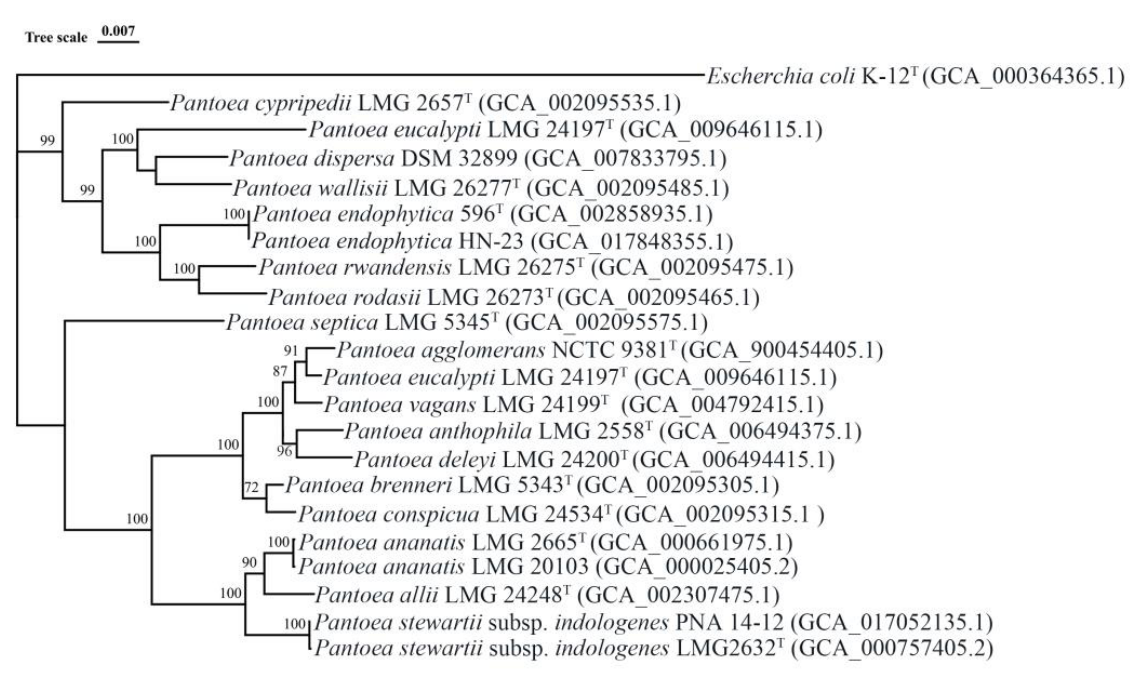
Figure 2. Phylogenetic tree of 18 species of Pantoea , based on 120 core genes using maximum composite likelihood. Nodes show the result of 1000 bootstrap replicates by IQ-TREE. Trees and dendrograms were visualized using ggtree and iTOL. Genomes from another strain were selected due to lacking the genomic information of the type strain of P. intestinalis and P. dispersa, while no genome information was available for P. coffeiphila .